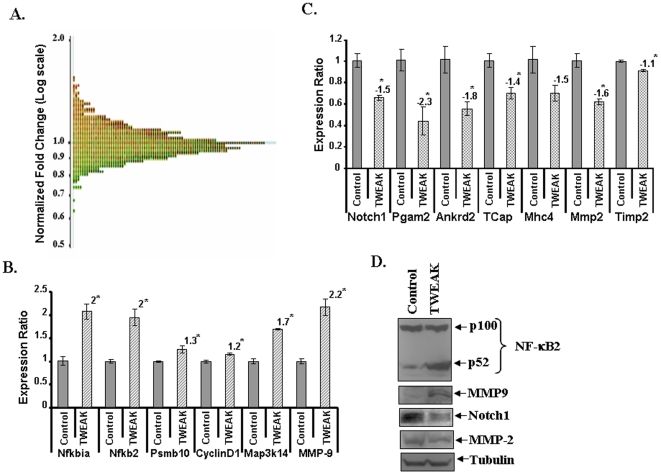
Differential expression of genes by TWEAK in C2C12 myotubes.A). Distribution curve of differentially expressed genes in response to TWEAK treatment detected by cDNA microarray analysis. The normalized fold changes were plotted on y-axis on logarithmic scale. B & C). C2C12 myotubes were treated with 10 ng/ml of TWEAK for 18h followed by isolation of total RNA and QRT-PCR. Untreated cells under similar conditions were taken as control. The relative expression values from the QRT-PCR analysis were plotted for each gene are mean ± SD (n = 3). The numbers above the bar represents the fold changes with TWEAK treatment against control, and ‘*’ represents the statistical significance (p-value ≤0.01). Data presented here show that mRNA levels of Nfkbia, Nfkb2, cyclinD1, Map3k14, and Mmp9 was significantly increased whereas the levels of Notch1, Pgam2, Ankrd2, TCap, Mhc4, Mmp2, and Timp2 are reduced in TWEAK-treated C2C12 cells. D). Differential expression of NF-κB2, MMP-9, Notch1, and MMP-2. C2C12 myotubes were treated with 10 ng/ml of TWEAK for 18h following isolation of total protein for Western blotting. All the samples were quantified and equal amounts of proteins were loaded on 10% SDS-PAGE gel. Representative immunoblots from three independent experiments (n = 3) presented here showed that TWEAK treatment increases the protein levels of NF-κB2 and MMP-9 and reduces the levels of Notch1 and MMP-2.